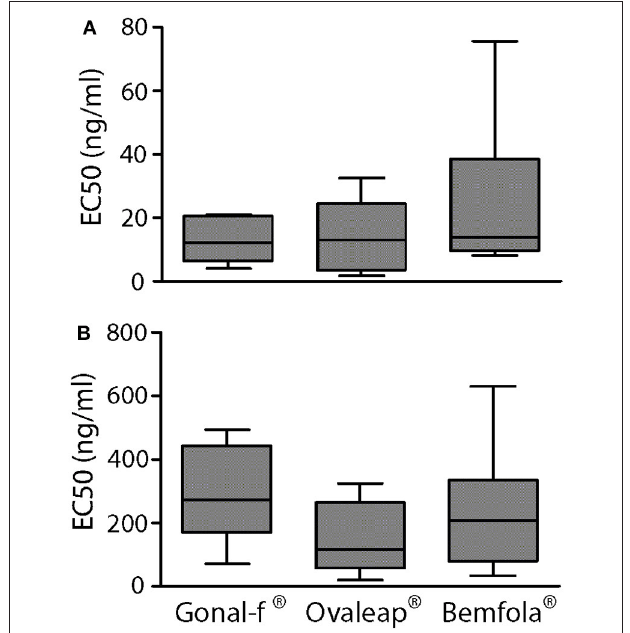
FIGURE 2 | EC 50 of cAMP response and β -arrestin 2 recruitment induced by Gonal-f ® and biosimilars in transfected HEK293 cells. (A) Cells were transiently co-transfected with FSHR and CAMYEL sensor. cAMP was measured by BRET after 30min stimulation with increasing doses of Gonal-f ® , Ovaleap ® , and Bemfola ® . (B) Cells were transiently co-transfected with FSHR-Rluc8 and β -arrestin 2 –YPET sensors. β -arrestin 2 recruitment was measured by BRET after 30min stimulation with increasing doses of hormones. EC 50 values were extrapolated by non-linear regression. Data are represented as box and whiskers graphs (Kruskal Wallis test, p ≥ 0.05; n = 4).